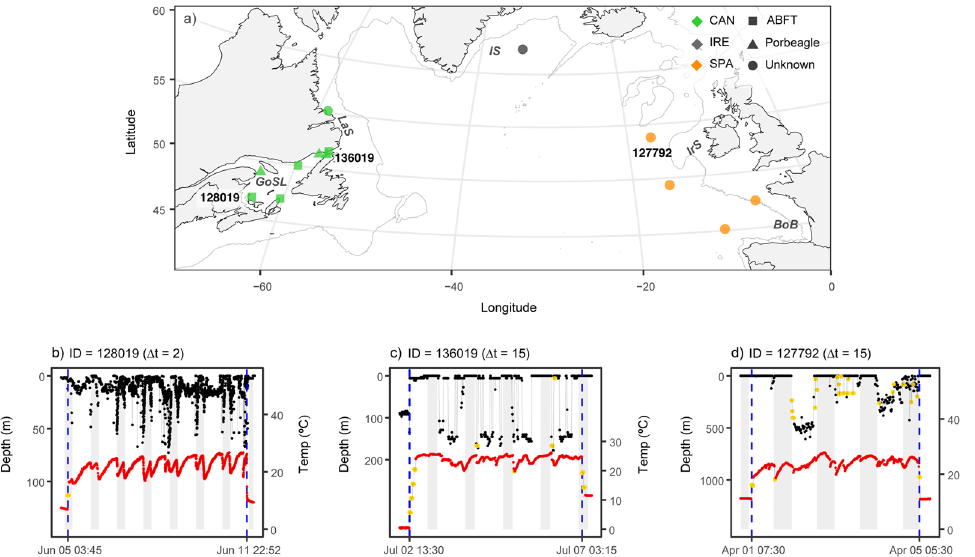
Figure 4. Predation by endothermic fish. ( a ) Pop-up locations for the tags consumed by endothermic fish, coded by predator type and origin. Grey lines indicate the 1000 m bathymetry contour. BoB = Bay of Biscay, GoSL = Gulf of St. Lawrence, IrS = Irish Shelf, IS = Irminger Sea, and LaS = Labrador Shelf. ( b ) Depth (black) and temperature (red) profiles for a tag consumed by an Atlantic bluefin tuna in the Gulf of St. Lawrence. ( c ) Depth (black) and temperature (red) profiles for a tag consumed by a porbeagle in the Northwest Atlantic Ocean. ( d ) Depth (black) and temperature (red) profiles for a tag consumed by an endothermic fish in the Northeast Atlantic Ocean. Yellow points indicate values distorted by the tags, blue vertical lines indicate time of ingestion and expulsion, and grey areas indicate night. Tag ID and temporal resolution of time series data ( Δ t) are stated above plot panels, and the corresponding Tag IDs are also indicated in panel